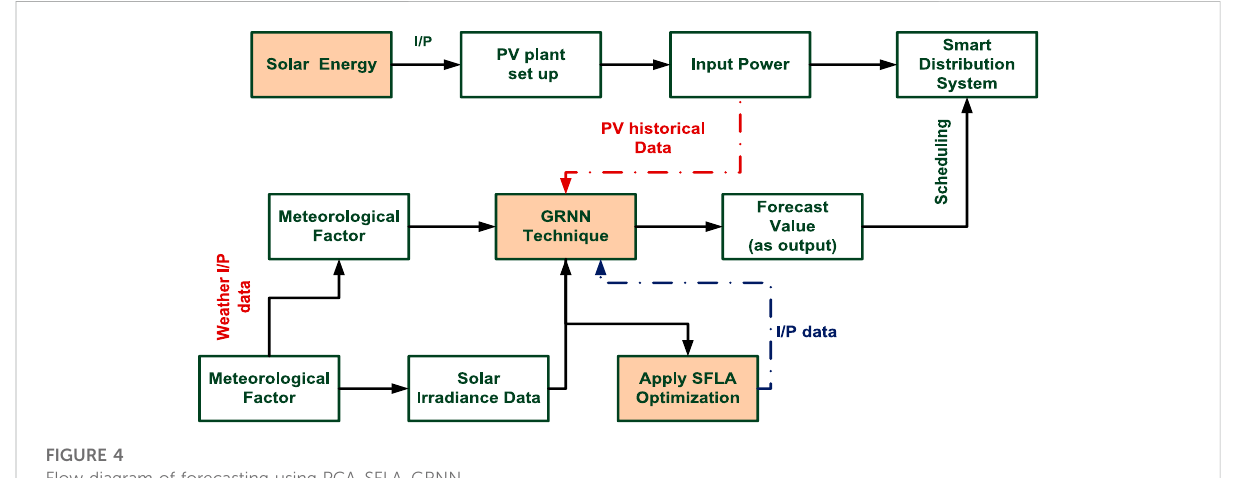
FIGURE 4 Flow diagram of forecasting using PCA-SFLA-GRNN.